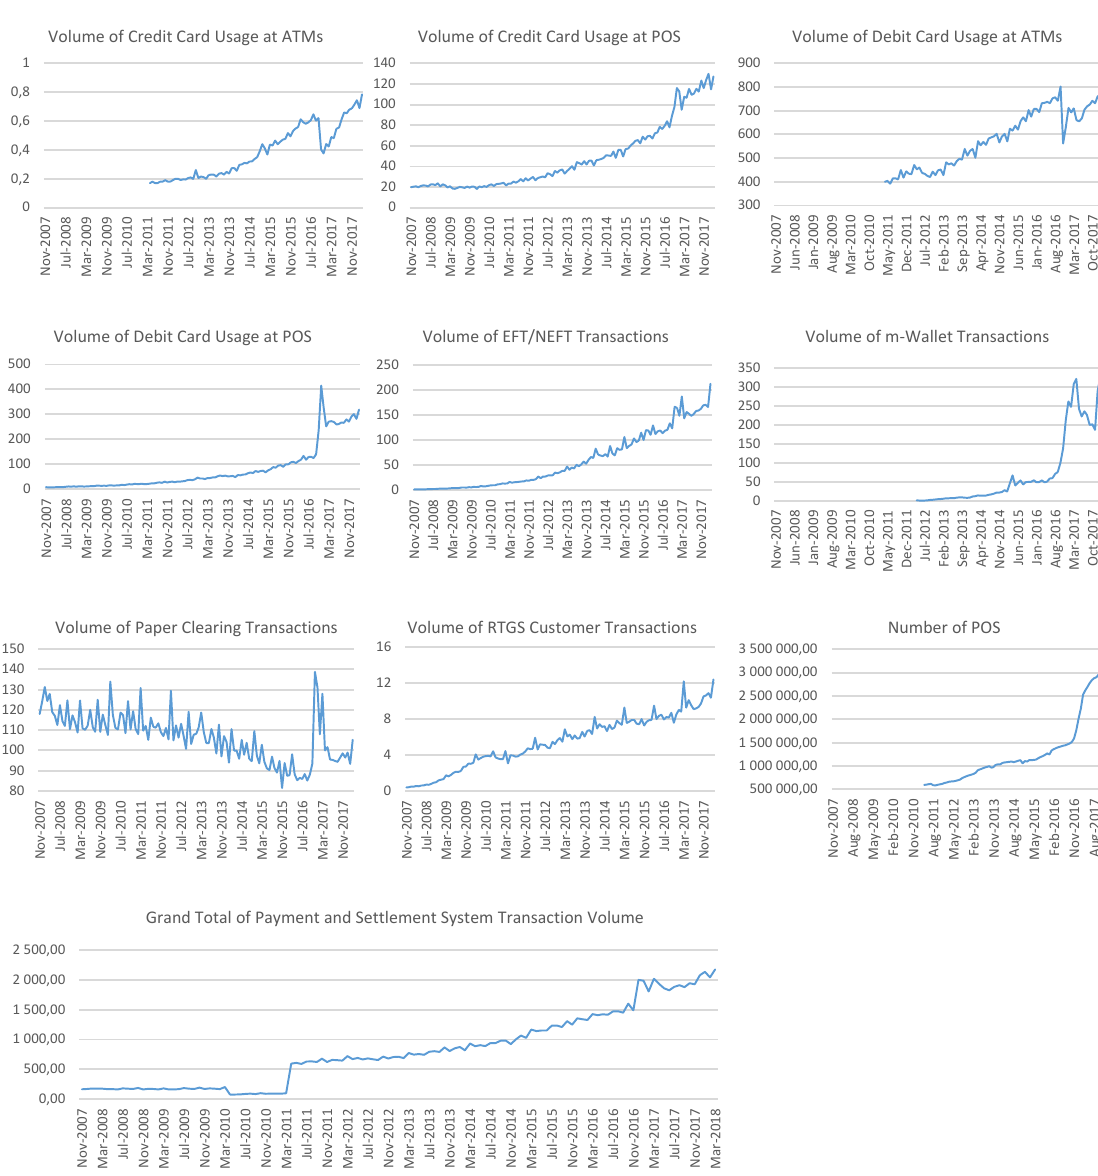
Figure 3. Trends in the volume of